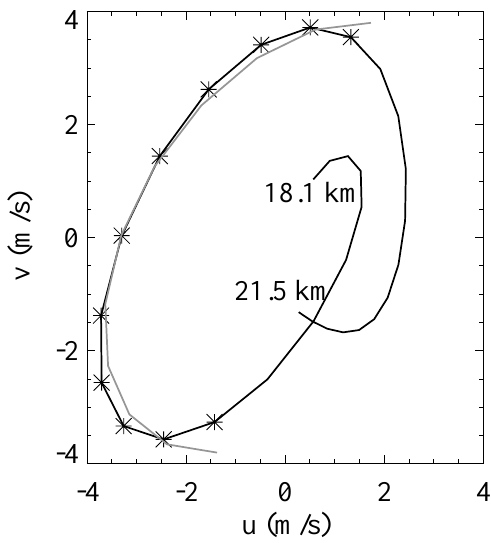
Fig. 3. Hodograph (black) of the wind fluctuations generated by the gravity wave. The stars show the region where the fit was made and the grey curve is the result of the fit (see text).